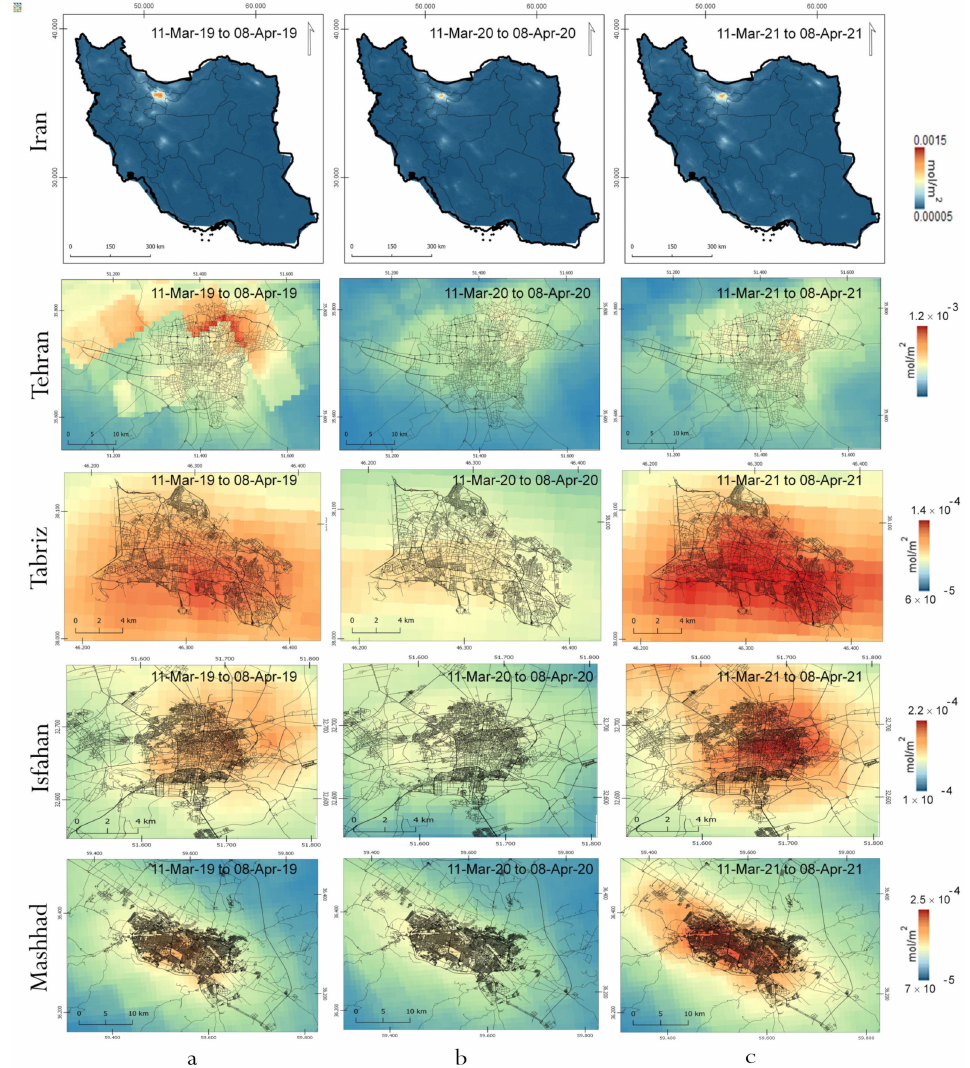
Figure 3. The comparative representations of the 30 day (11 March–8 April) average value of NO 2 over the entire country of Iran and its four districts (Tehran, Tabriz, Isfahan, and Mashhad) in ( a ) 2019, ( b ) 2020, and ( c )